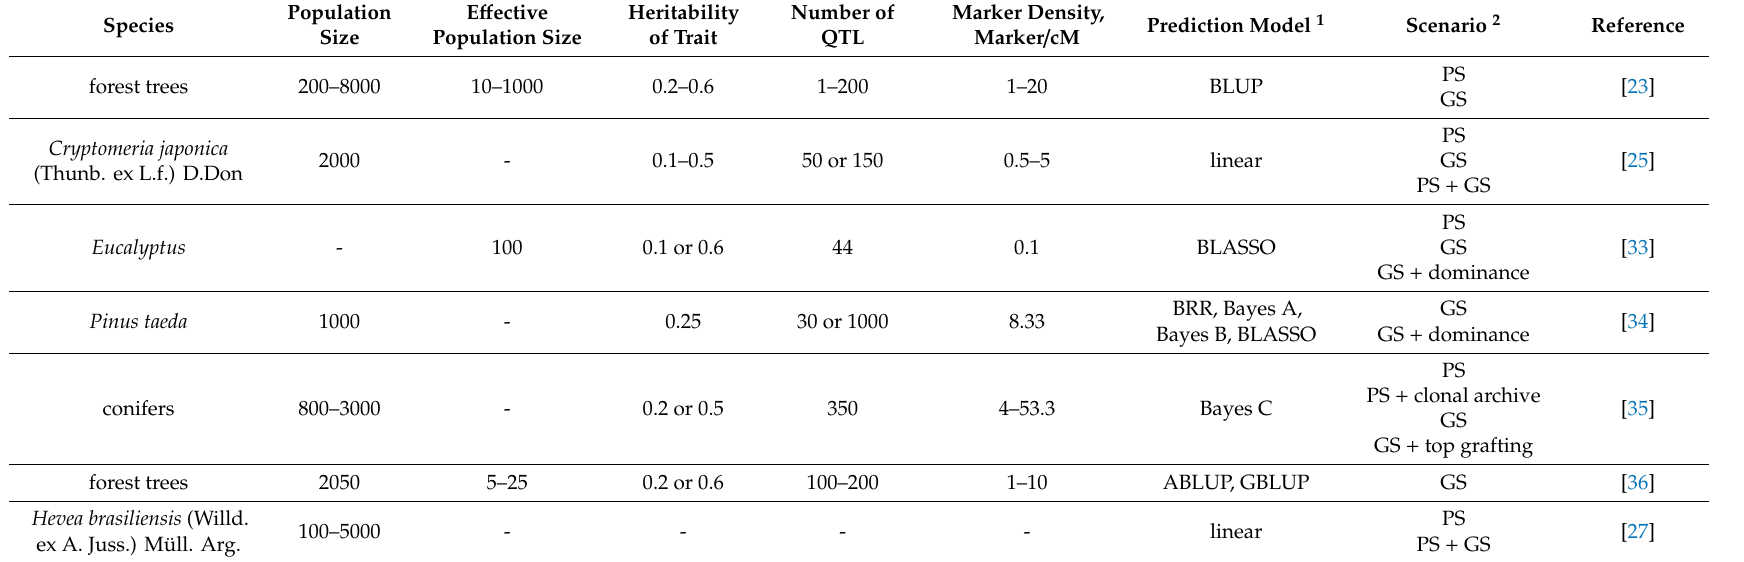
Table 1. Summary of the published simulation studies on GS in forest trees.